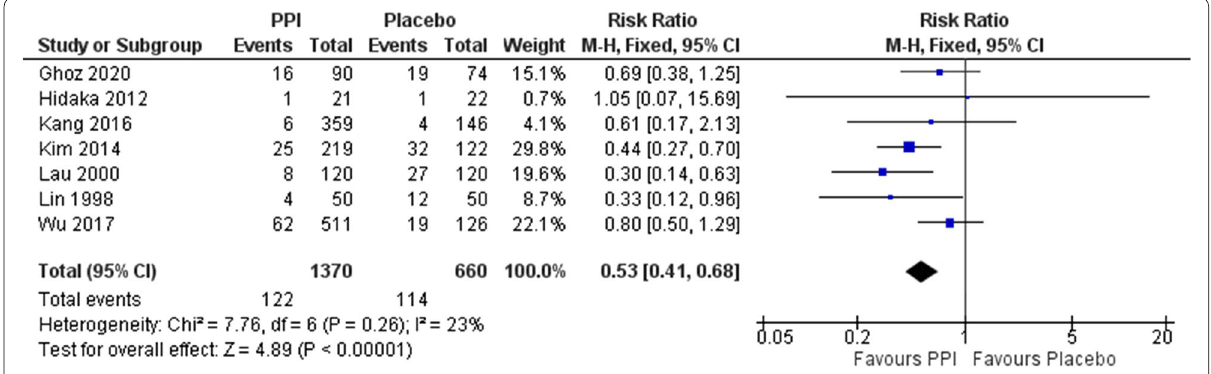
Fig. 4 Forest plot for rebleeding post-band